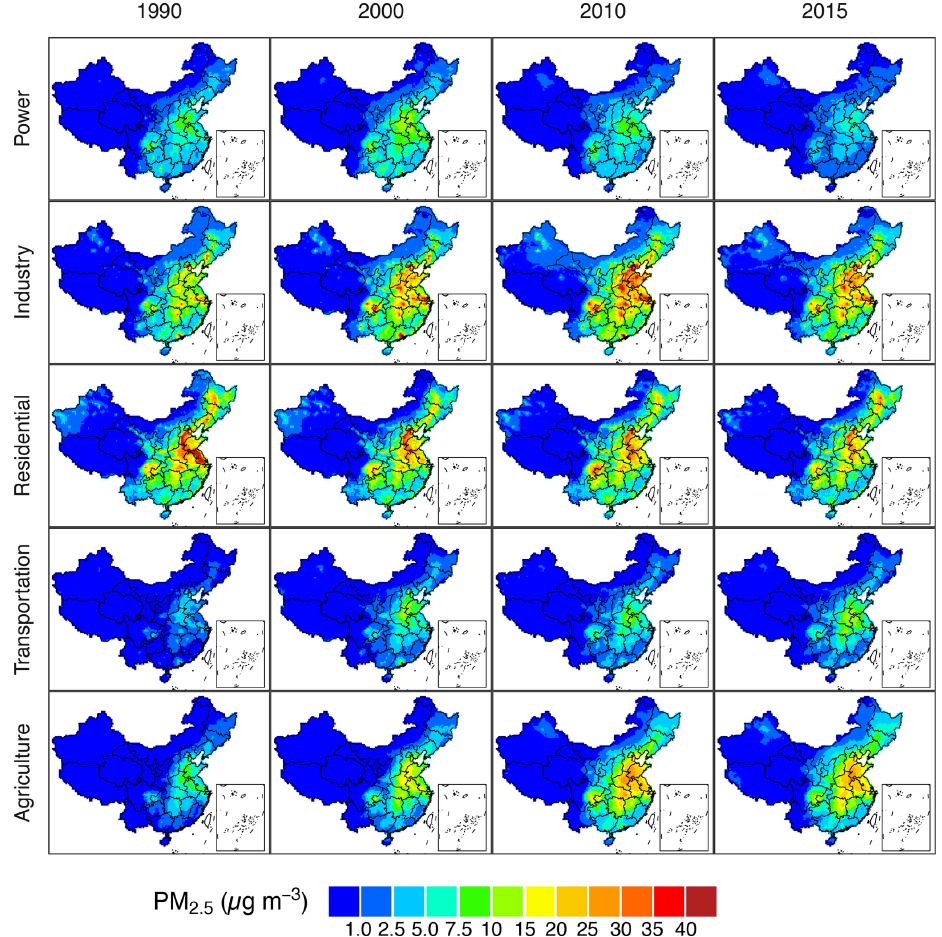
Figure 4. Source contributions to annual average PM 2 . 5 concentration (µgm − 3 ) in 1990, 2000, 2010, and